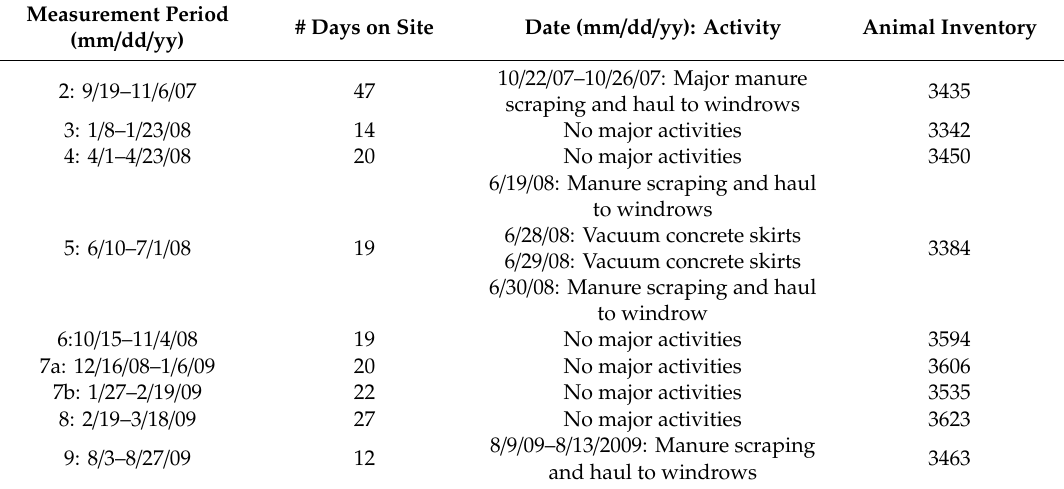
Figure 1. Farm layout and configuration of measurements. Locations of the TDL / scanners (labeled TS1 and TS2) and retro-reflectors (labeled N1, W1, E1, E2) and sonic anemometers (triangles) are indicated. Dashed lines indicate optical paths. The meteorological station was located at M. Table 1. Producer activities during measurement